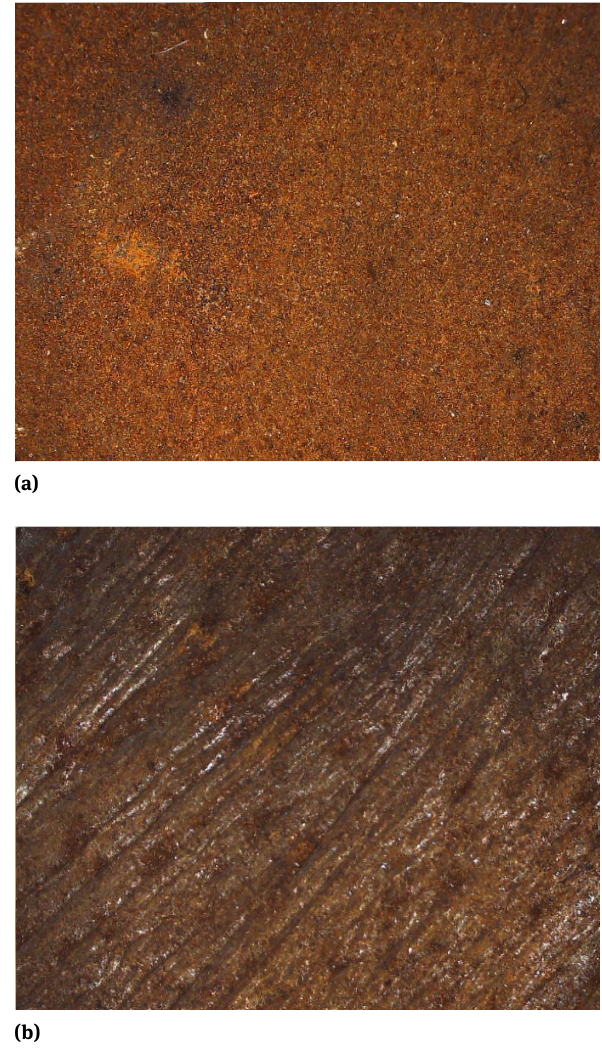
Figure 7: Optical macroscopic image of LCS (a) before corrosion test, (b) after corrosion from 0.5 M H2SO4 solution and after corrosion from 0.5 M HCl solution (mag. × 20)